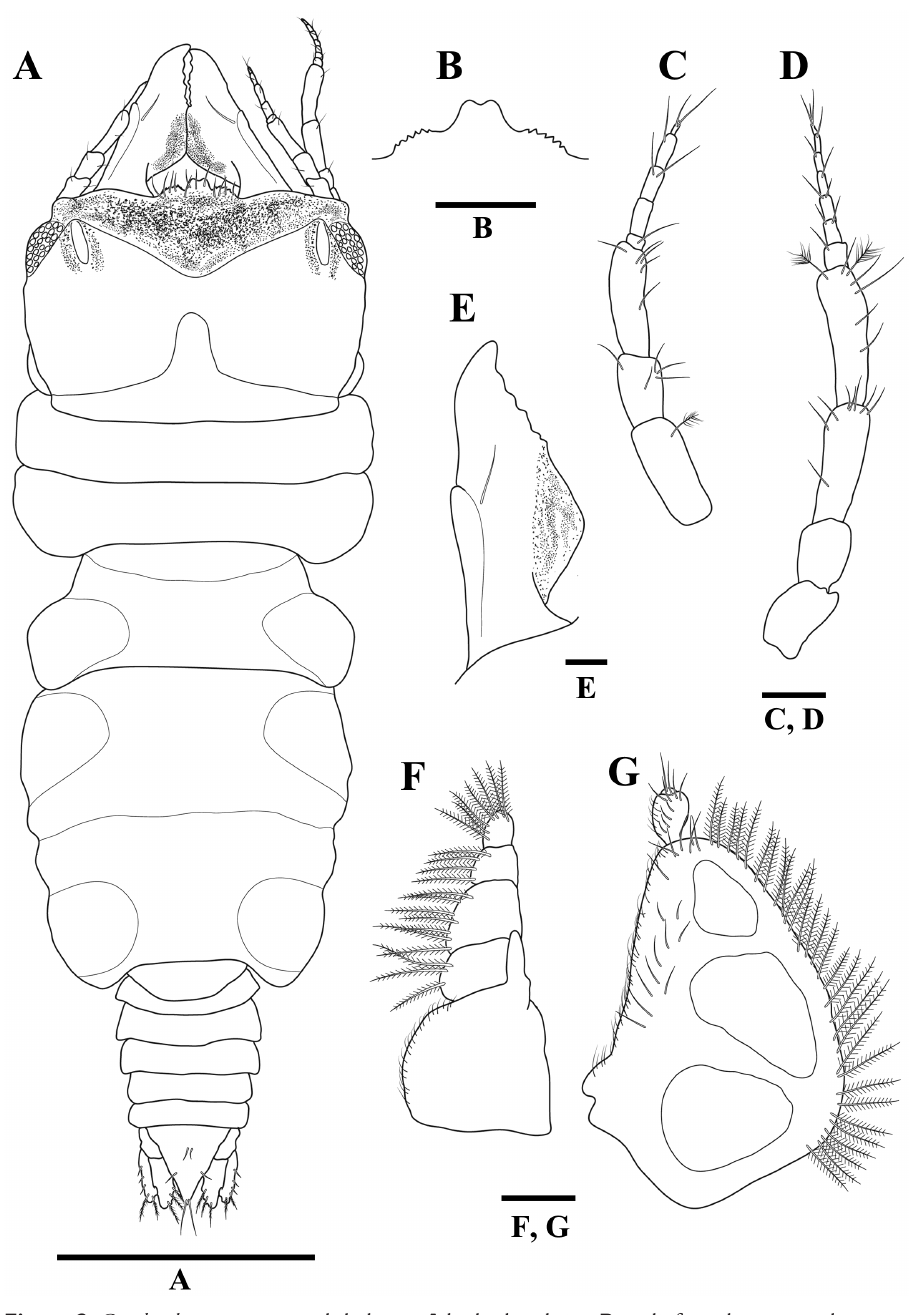
Figure 2. Gnathia koreana sp. n., male holotype A body, dorsal view B mediofrontal process and superior frontolateral process C antennula D antenna E mandible F maxilliped G pylopod. Scale bars: 1 mm ( A ), 0.5 mm ( B ), 0.1 mm ( C–E ), 0.2 mm ( F, G